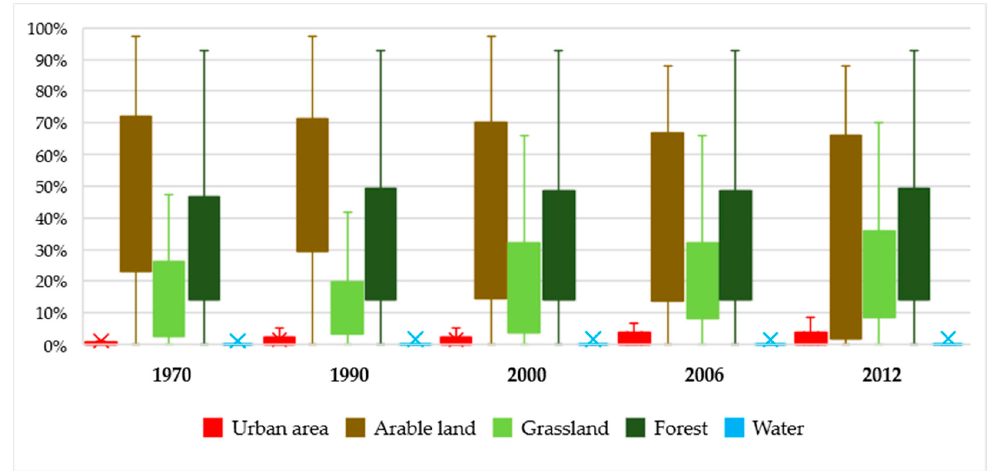
Figure 6. Average percentage values of land use categories representation in all checked cadastral territories for individual years based on the Corine Land Cover Analysis.